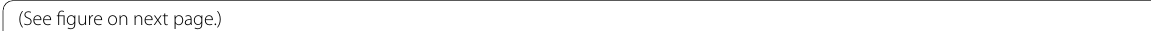
Fig. 1 A phylogenetic tree demonstrating the linkages between species and genera within the family Closteroviridae on the basis of the amino acids sequence of RdRp. A multiple sequence alignment of RdRp amino acids sequence was performed using CLUSTALW. A phylogenetic tree was constructed with MEGA7 software using the neighbor-joining method and bootstrapped 1000 times. The numbers on nodes particularly signify bootstrapped confidence percentages. The abbreviations and accession numbers of closterovirids involved in this tree: Actinidia virus 1 (AcV-1; YP_009407919.1); Air potato virus 1 (AiPoV-1; AZB50207.1); Areca palm velarivirus 1 (APV-1; YP_009140432.1); Bean yellow disorder virus (BnYDV; YP_001816770.1); Beet pseudo yellows virus (BPYV; NP_940796.1); Blueberry virus A (BVA; YP_006638806.1); Blackberry vein banding-associated virus (BVBaV; YP_008411010.1); Beet yellow stunt virus (BYSV; AAC55659.2); Beet yellows virus (BYV; AAF14300.1); Blackberry yellow vein-associated virus (BYVaV; YP_227378.1); Cucurbit chlorotic yellows virus (CCYV; AFN61343.1); Cordyline virus 1 (CoV-1; YP_009506344.1); Cordyline virus 2 (CoV-2; AFJ05046.1); Cordyline virus 3 (CoV-3; AFJ05056.2); Cordyline virus 4 (CoV-4; AFJ05062.2); Carnation necrotic fleck virus (CNFV; YP_009506332.1); Citrus tristeza virus (CTV; ANA04448.1); Carrot yellow leaf virus (CYLV; YP_003075965.1); Cucurbit yellow stunting